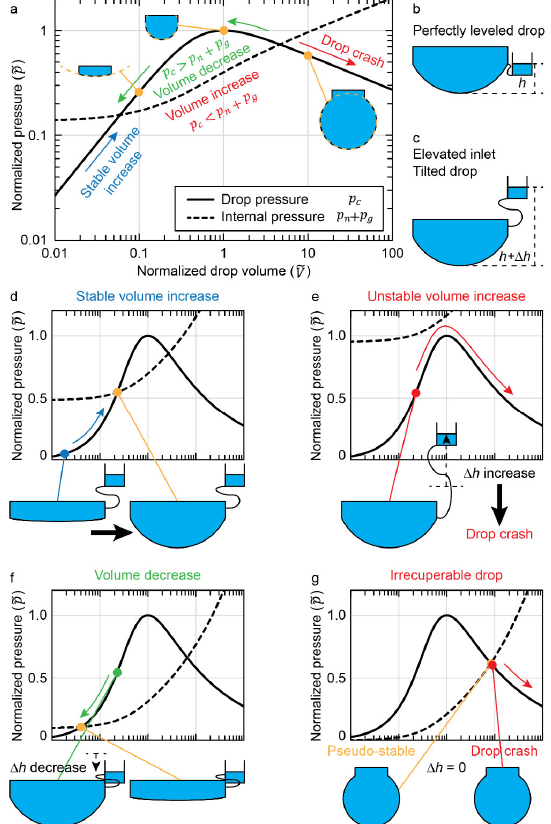
Figure 4. Dynamics of a hanging-drop crash. ( a ) Logarithmic-scale plot of the pressure, normalized by the maximum capillary pressure of a hemispherical drop ( = (2 ⁄ )⁄ ), as a function of the volume of a hanging drop, normalized by the volume of a perfectly hemispherical drop ( = ( 2 3 ⁄ )⁄ ). The normalized drop capillary pressure (black line) and the normalized drop in- ternal pressure of the drop network + (2 ⁄ )⁄ (dashed black line) are plotted. is inde- pendent of the drop design and is only dependent on the normalized drop volume . The internal pressure is given for a distorted hanging drop of 3.9 mm aperture diameter at 37 °C and subjected to a hydrostatic pressure of a 1 mm-high water column. ( b ) Schematic representation of a hanging drop, connected to a perfectly leveled reservoir. In this case, the drop would empty into the reservoir until the bottom of the ALI would be perfectly flush with the drop aperture. ( c ) Schematic represen- tation of the typical-case scenario, where hydrostatic pressure comes from the drop height and any height difference to the microfluidic network Δℎ . ( d – g ) Plot of the normalized pressure on a linear scale with the normalized volume on a logarithmic scale. ( d ) Case of a stable drop volume increase. ( e ) Case of an unstable volume increase following an increase in internal pressure, causing the drop to crash. ( f ) Case of a volume decrease following a decrease in internal pressure. ( g ) Case of an irrecuperable drop, if the drop height cannot be reduced below the drop aperture height. A pseu- dostable state exists but diverges easily to a drop crash.